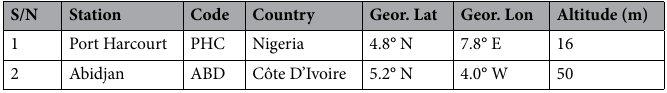
Table 1. Coordinates of climate data